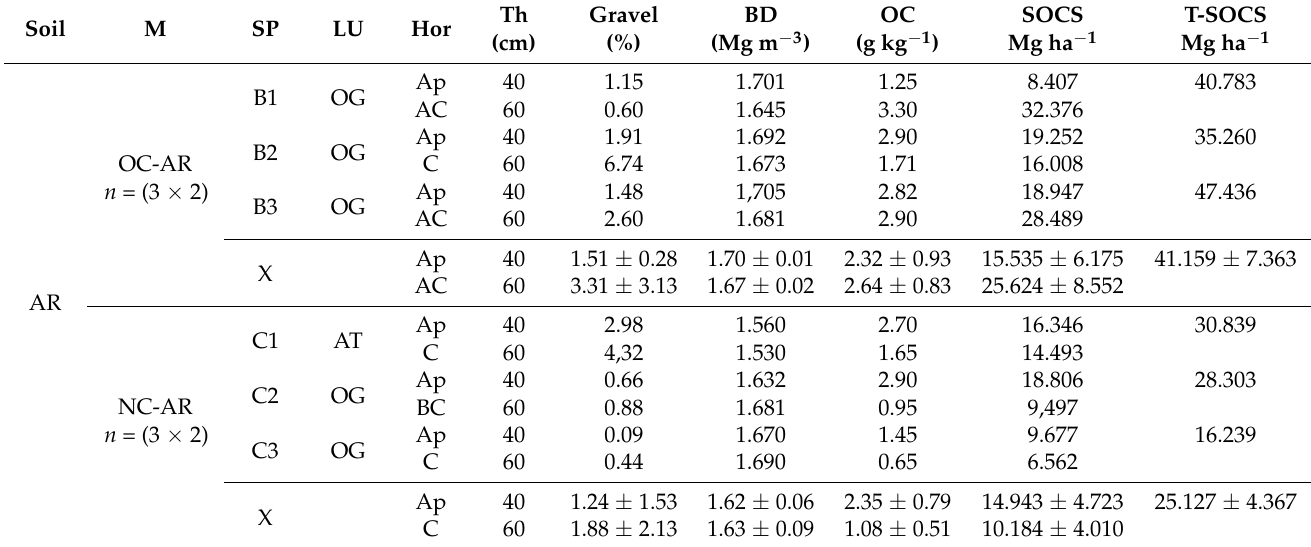
Table 6. Soil organic carbon stock in Arenosols.